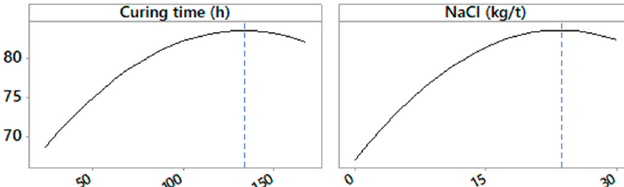
Figure 5. Settings and sensitivity for optimal solution for Mn recovery (%).